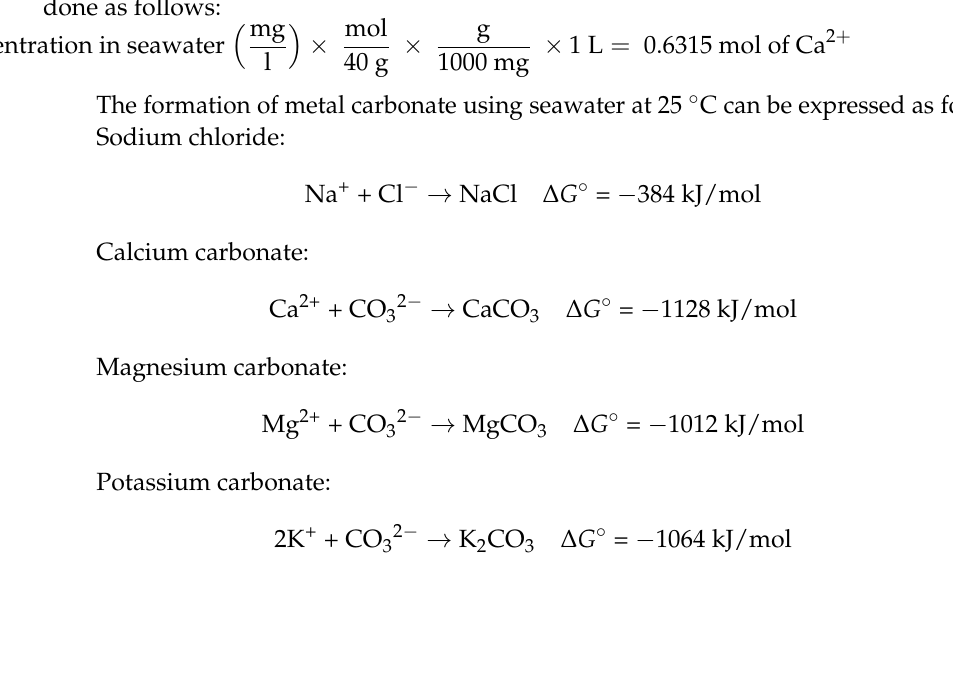
Figure 5. SEM image of carbonate in 5 wt % MEA solution. The formed CaCO 3 was not visible, because of the sodium chloride ( a ). However, it appears differently in ( b ) because of washing the NaCl. ( b ) shows the CaCO 3 : ( a ) correspond to not washed carbonate and ( b ) to washed carbonate. (N: NaCl, C: calcite, V: vaterite).